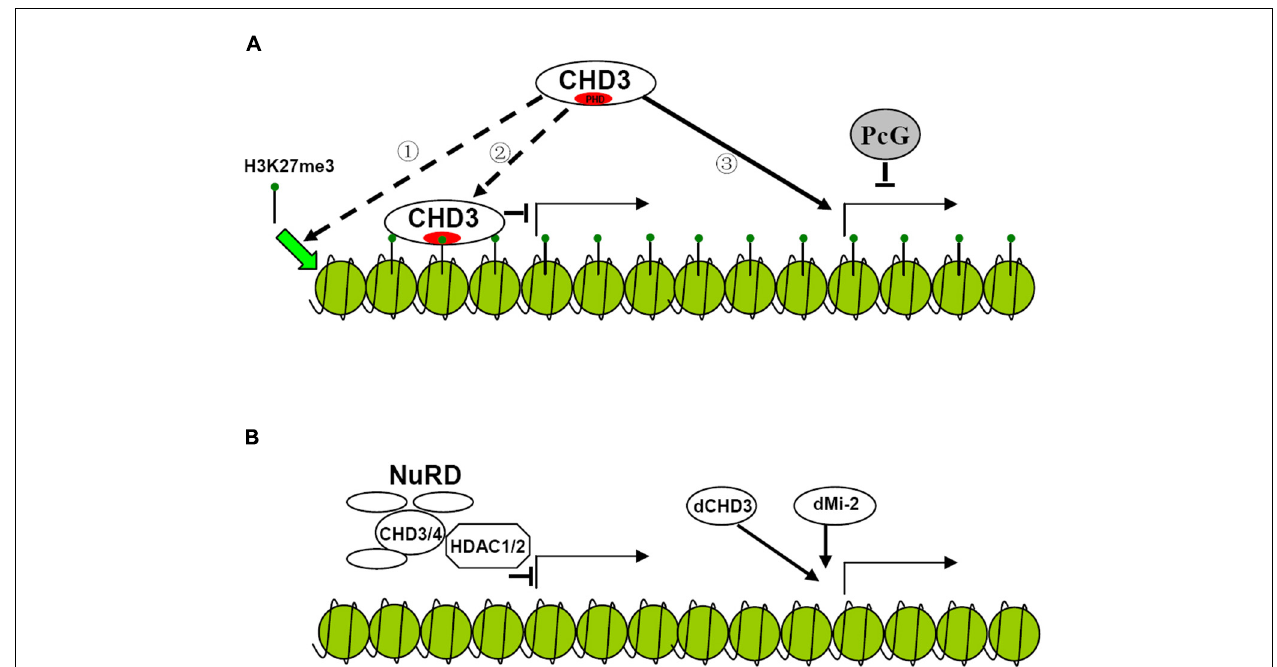
FIGURE 2 | Possible models for the regulation of gene transcription by CHD3 protein in plant and animal. (A) Hypothesized model for the regulation of gene transcription by plant CHD3 proteins. Plant CHD3 proteins act as monomer to repress or activate gene expression. The repression involves the association with H3K27me3 by PHD domain. However, it is not known whether the binding of CHD3 protein to H3K27me3 is necessary for the deposition of the mark 1 (cid:2) or serves as a